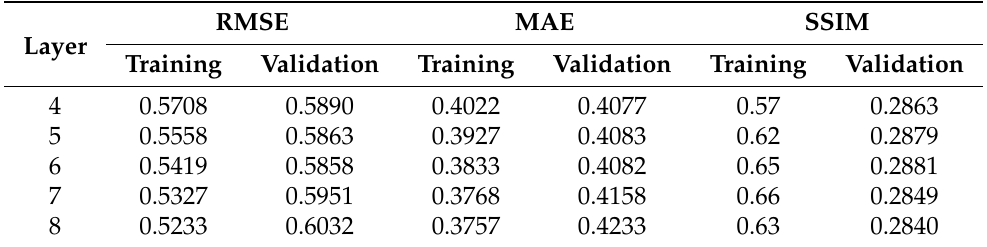
Table 3. Comparison of models with different layers over 24 prediction steps.